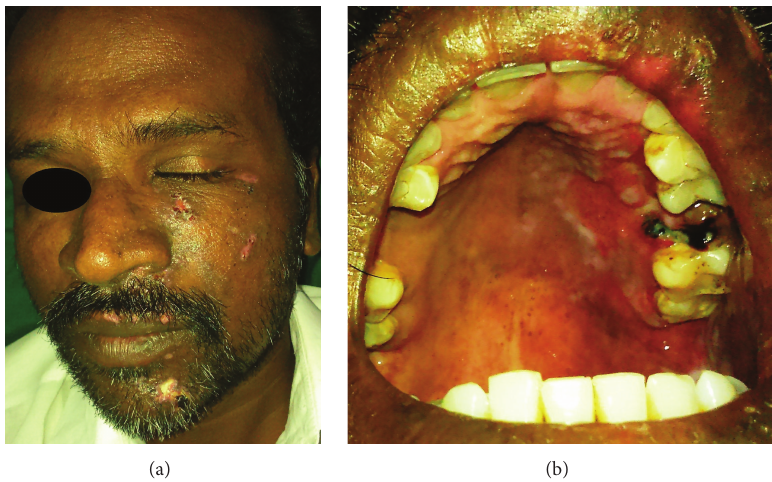
Figure 4: After one week of treatment with antivirals and steroids.